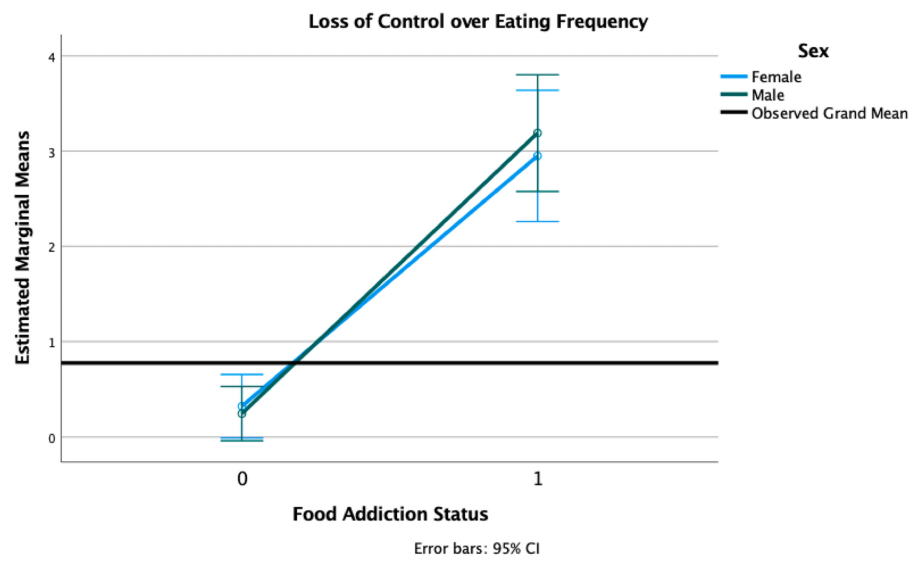
Figure 2. Estimated marginal means of loss of control over eating frequency for a 2 × 2 factorial ANOVA with sex (female, male) and FA status (1 = positive, 0 = negative, on the X -axis) adjusted for age, race, and PTSD status (threshold vs.